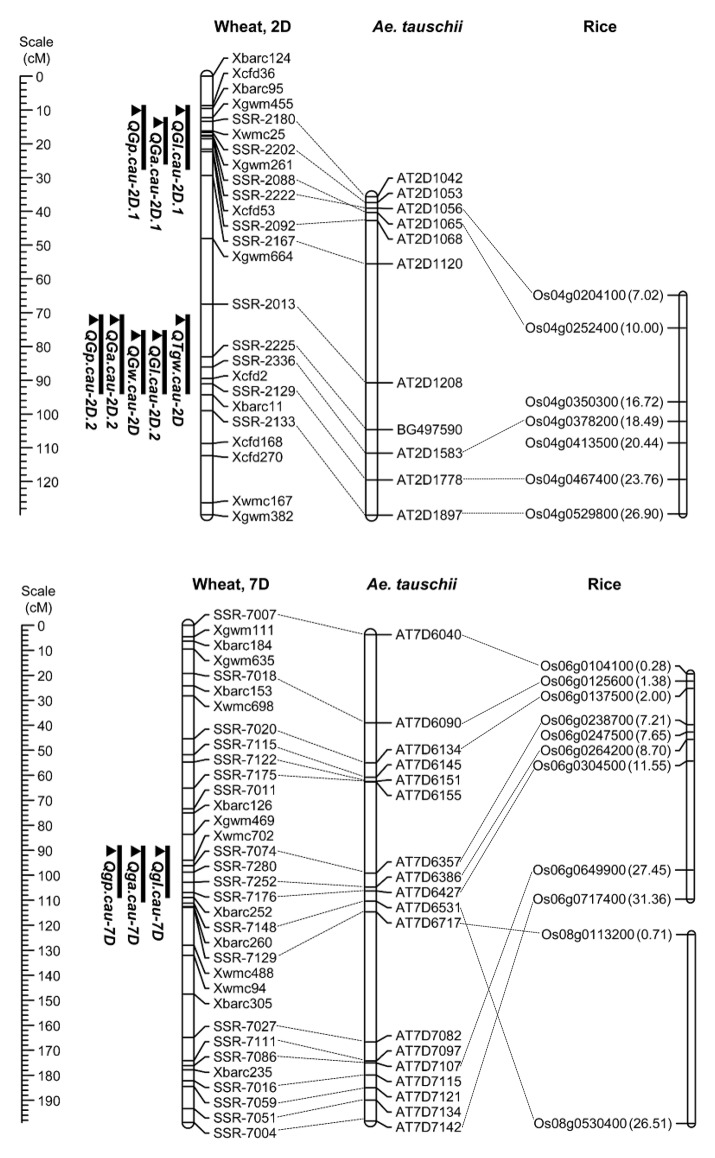
Locations of the detected QTL on the chromosome 2D and 7D in the F2:3 population and the collinearity of the developed markers, Ae. Tauschii markers and rice genes. A centiMorgan (cM) scale is shown on the left. The black ellipse represents the approximate location of the centromere. Vertical bars show the confidence intervals for the location of each QTL with LOD from the top to 3.0.